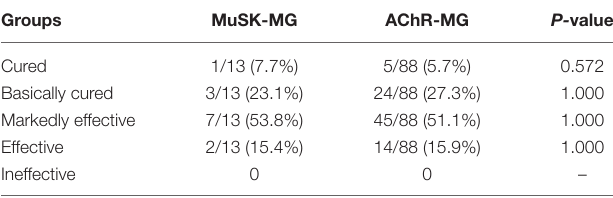
TABLE 5 | Comparison of the prognosis after steroid combined with immunosuppressive therapy between MuSK-MG and AChR-MG group.